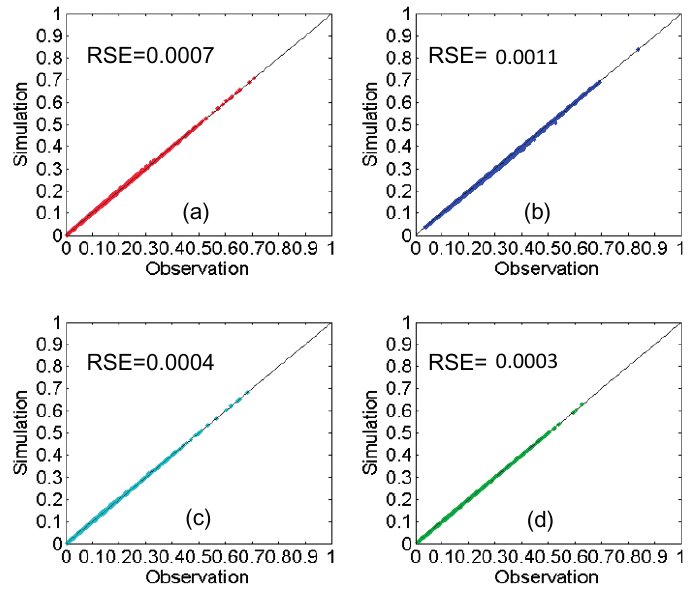
Figure 3. CASI reflectance comparisons between the simulations and observations: ( a ) Band 1; ( b ) Band 2; ( c ) Band 3; ( d ) Band